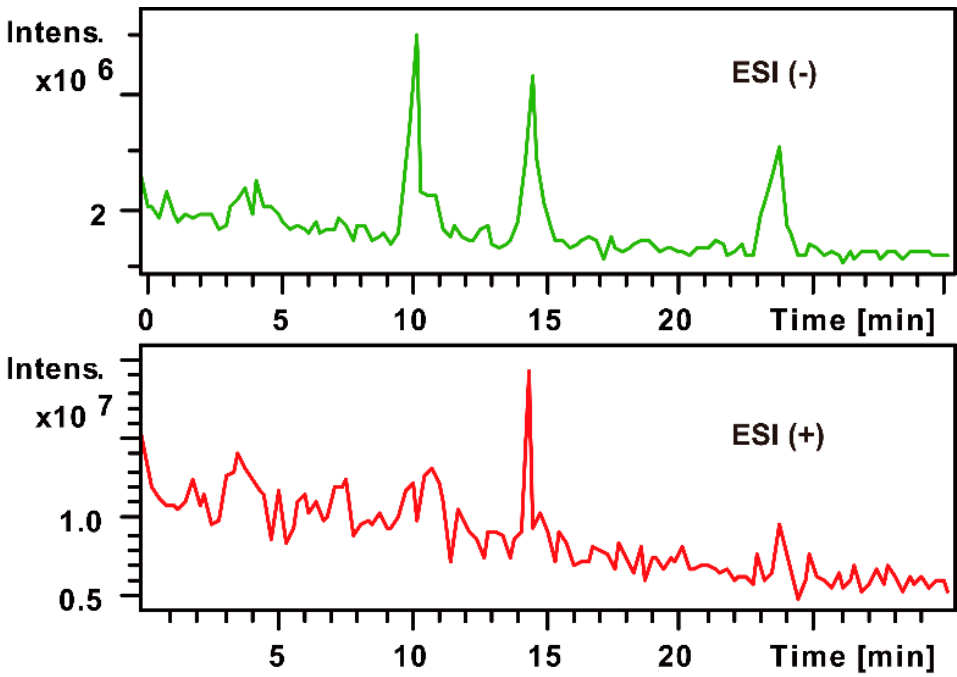
Figure 2. Positive and negative total ion current chromatogram (TIC) of three double PMP-labeled monosaccharides.